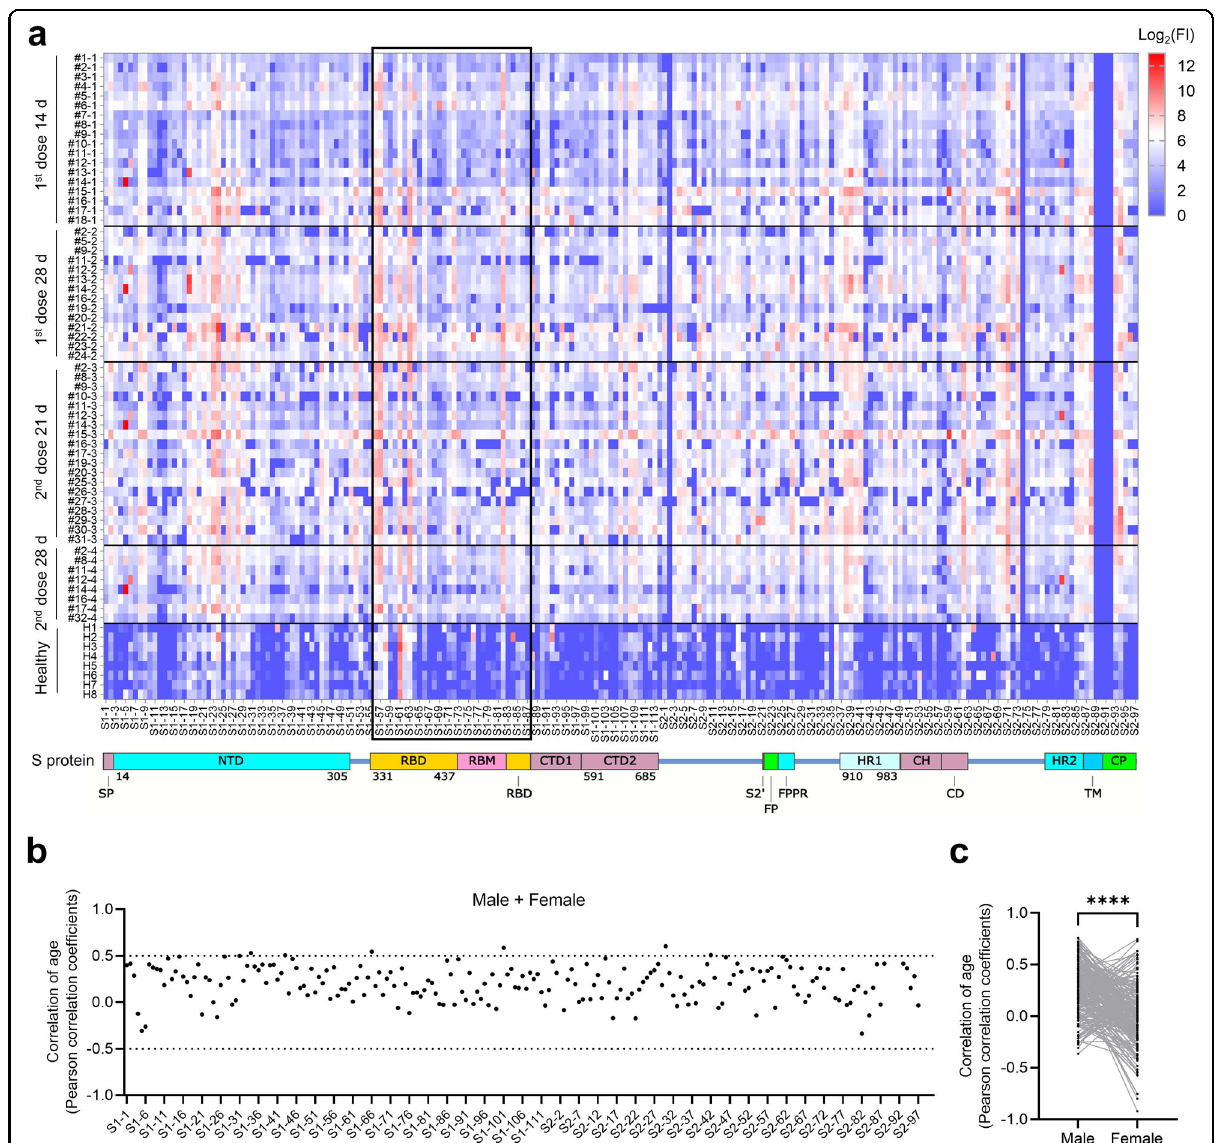
Fig. 3 IgG responses to S protein peptides in vaccinated volunteers. a IgG responses of vaccinated individuals against S protein peptides. FI, fl uorescence intensity, was shown in log scale, i.e., log fi cient between the peptide-speci fi c IgG response 2 (FI) ranges from 0 to 12. b Correlation coef and age. c Correlation coef fi cients for male and female. Each line represents one